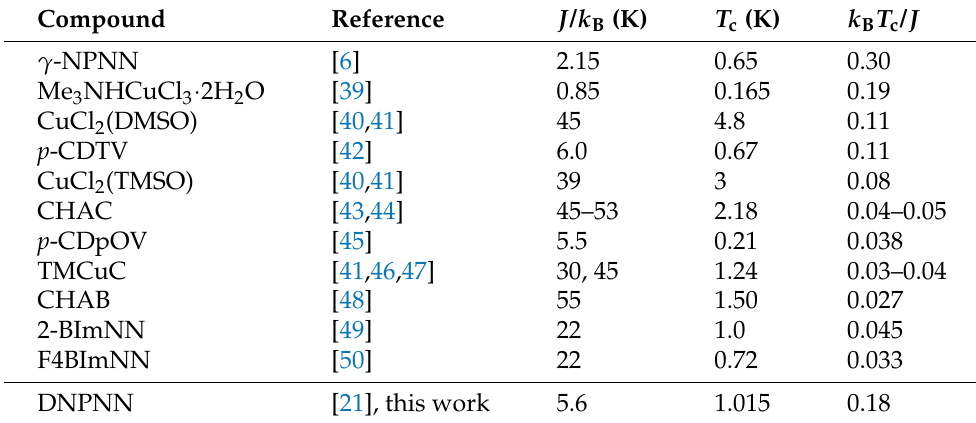
Table 2. Magnetic properties of selected one-dimensional ferromagnets. p -NPNN =